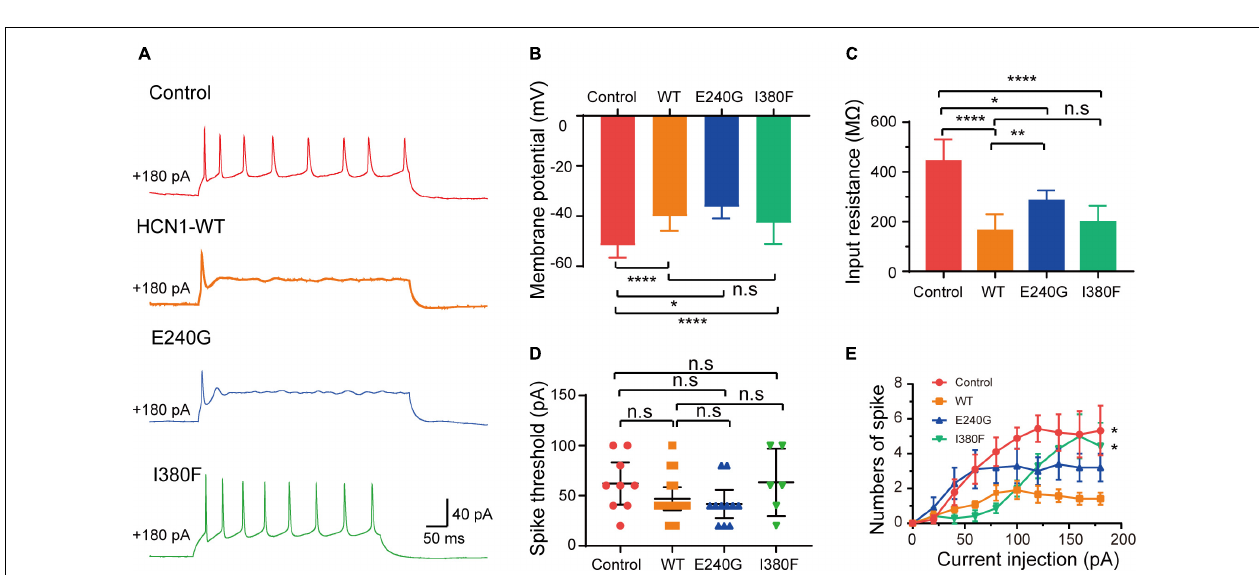
FIGURE 7 | Hyperpolarizing voltage sag in cortical neurons expressing WT and mutant channels. (A) Representative recordings of voltage sag in response to a − 100 pA hyperpolarizing current injection in WT and mutant HCN1 -transfected neurons. (B) Bar graph shows mean voltage sag ratios for different types of HCN1 channels. *** P < 0.005, **** P < 0.001.